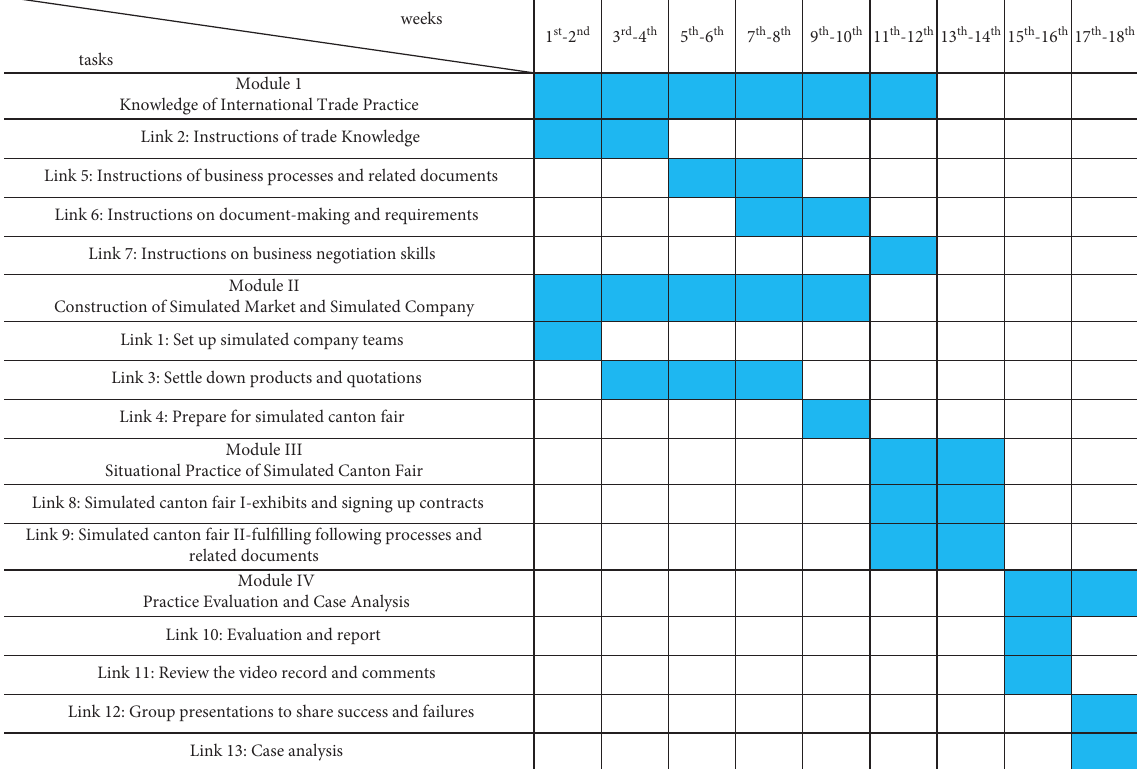
Figure 3: The experiment and innovated teaching plan (Gantt chart).